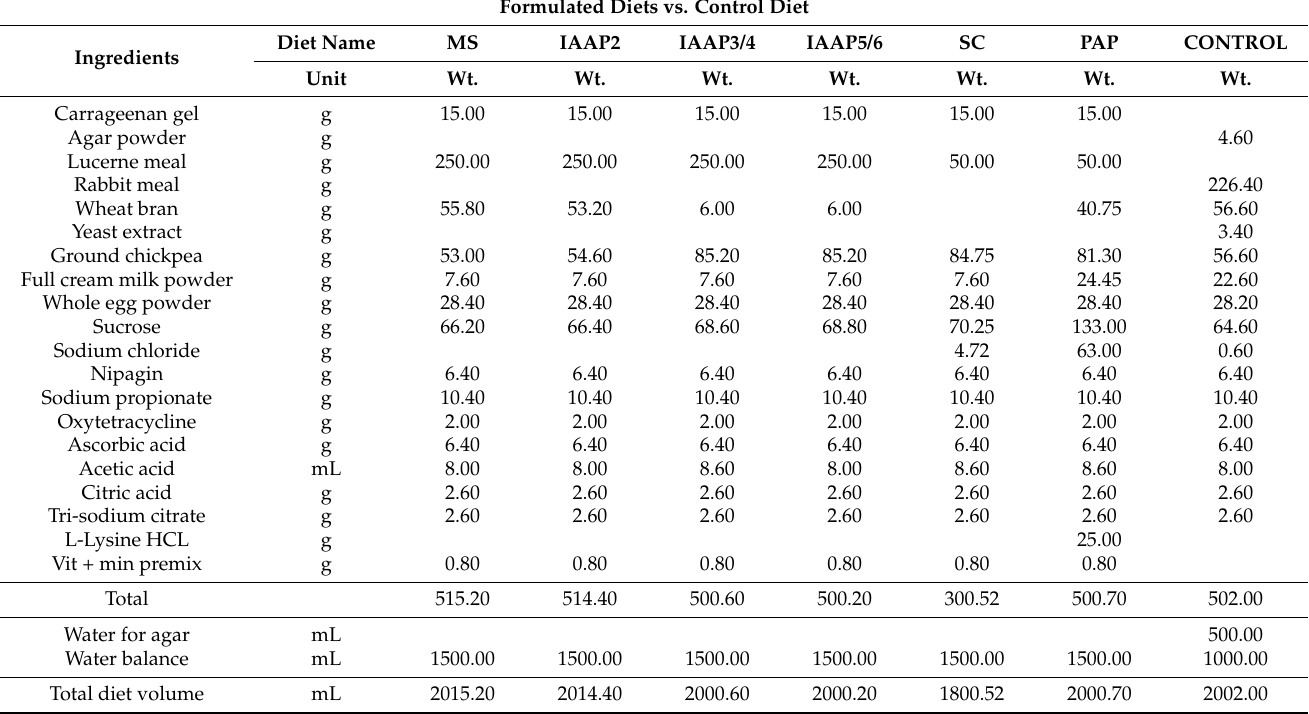
Table 1. Ingredients and weights (Wt) required for preparing the formulated Eldana saccharina and Control diets (MS = minimum specifications diet; IAAP2 = ideal amino acid profile of second instar E. saccharina larvae based diet; IAAP3/4 = ideal amino acid profile of third and fourth instar larvae based diet; IAAP5/6 = ideal amino acid profile of fifth and sixth instar based diet; SC = diet based on the analysis of sugarcane (host plant); PAP = diet based on the analysis of Cyperus papyrus (host plant). Formulated Diets vs. Control Diet